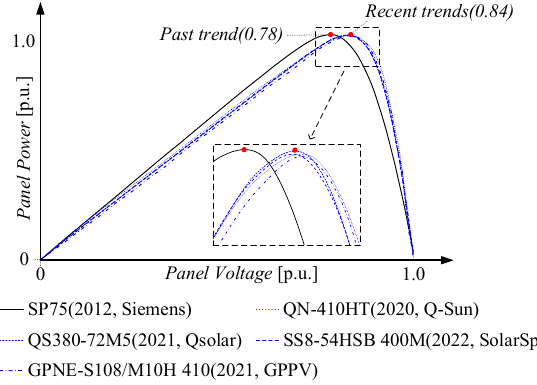
Figure 3. Comparison of PV panel property curve trends.